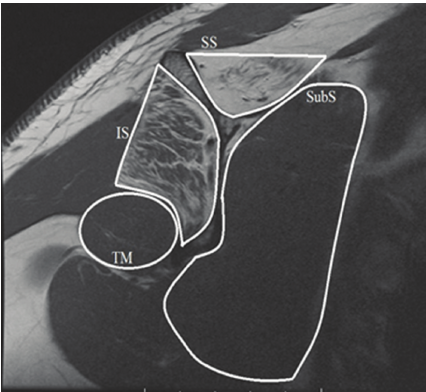
Figure 3: T1 sagittal oblique MRI image of rotator cu ff mus- cles, demonstrating fatty infiltration of the supraspinatus and infraspinatus muscles. IS, infraspinatus; SB, subscapularis; SS, supraspinatus; TM, teres